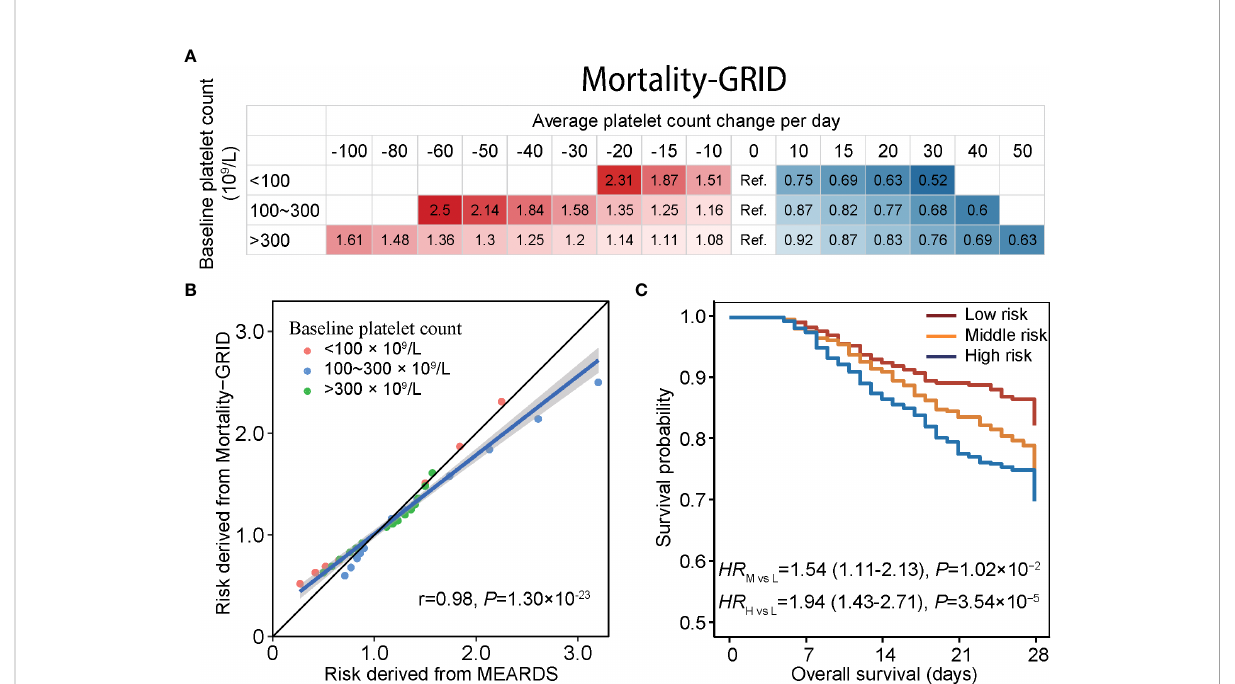
FIGURE 4 Mortality-GRID and validation in the MEARDS database. (A) Mortality-GRID. Patients with no change in platelet count per day were set as the reference group, the values in each cell represent hazard ratios of platelet count changes per day derived from restricted cubic spline regression. (B) Consistency between mortality risks estimated by Mortality-GRID and MEARDS database presented by scatter plot. (C) Estimated survival curves for patients in the MEARDS database. The mortality risks of MEARDS patients were independently predicted by Mortality-GRID and categorized into low-, medium-, and high-risk groups using the